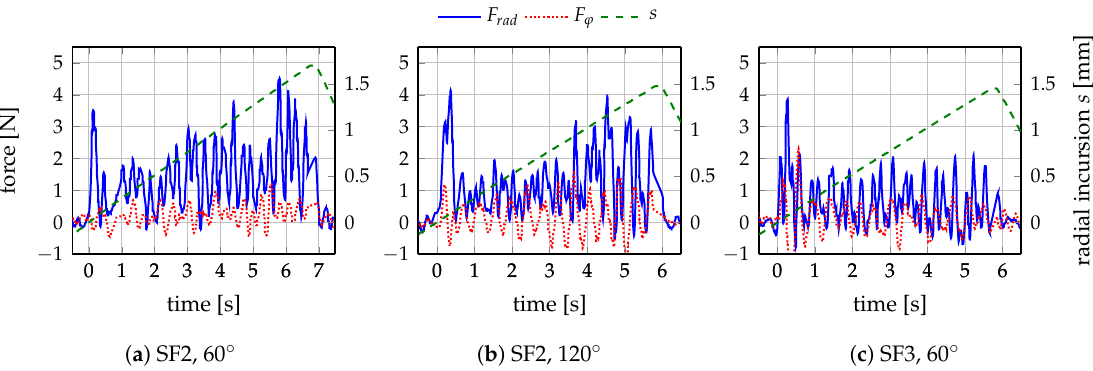
Figure 6. Radial and tangential forces and radial incursion over time for reference rub scenario